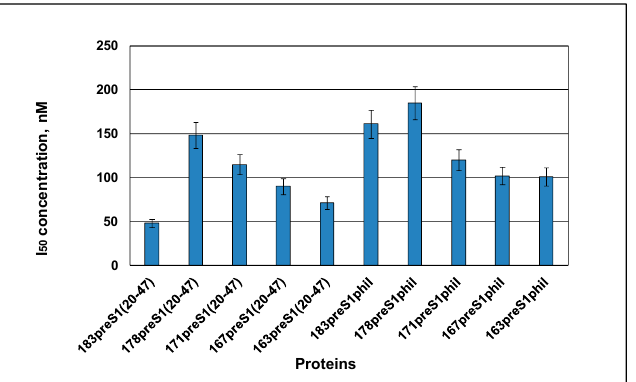
Figure 9. The preS1 antigenicity of the HBc-preS1 VLPs. The VLP concentration necessary and suf-